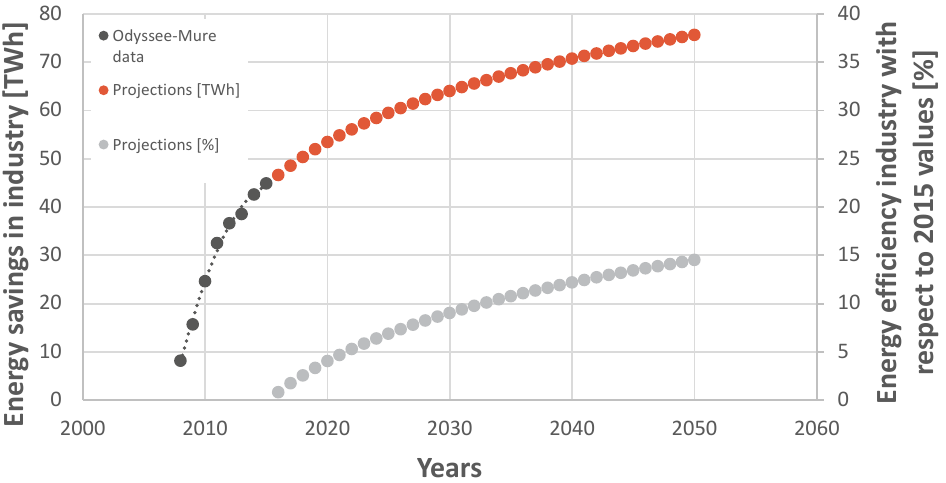
Figure 6. Energy efficiency in the industry sector: historical data and projections to 2050 through a logarithmic interpolation.